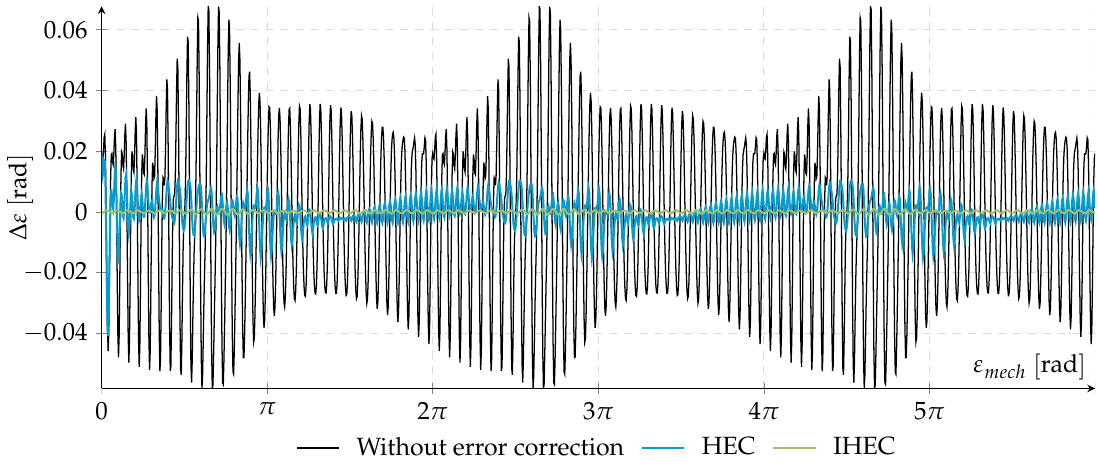
Figure 9. Simulation results of the difference between the real and the estimated